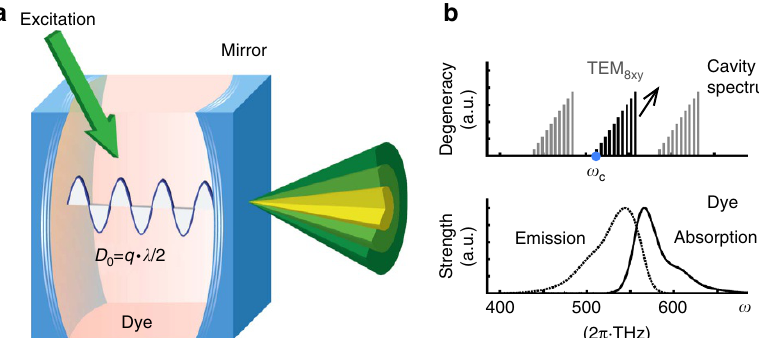
Figure 1 | Bose–Einstein condensation of a two-dimensional photon gas. ( a ) Photons are captured inside a microcavity consisting of two spherically curved mirrors and get repeatedly absorbed and re-emitted by the embedded dye medium, leading to a thermalization of the photon gas to the temperature of the resonator (room temperature). ( b ) The short cavity length causes a large frequency gap between the longitudinal resonator modes (free spectral range) of order of the emission bandwidth of the dye molecules. In this situation, the resonator becomes populated by photons of a single longitudinal mode number only, here q ¼ 8. However, the photons may still populate a multitude of transversally excited cavity modes (TEM 8xy sub-spectrum), which effectively makes the photon gas two-dimensional. Above a critical photon number, the photon gas undergoes a Bose–Einstein condensation, leading to a massive population of the cavity ground mode (TEM 800 ). Thermodynamic information is obtained by spectroscopically analysing the photon energy distribution across the phase